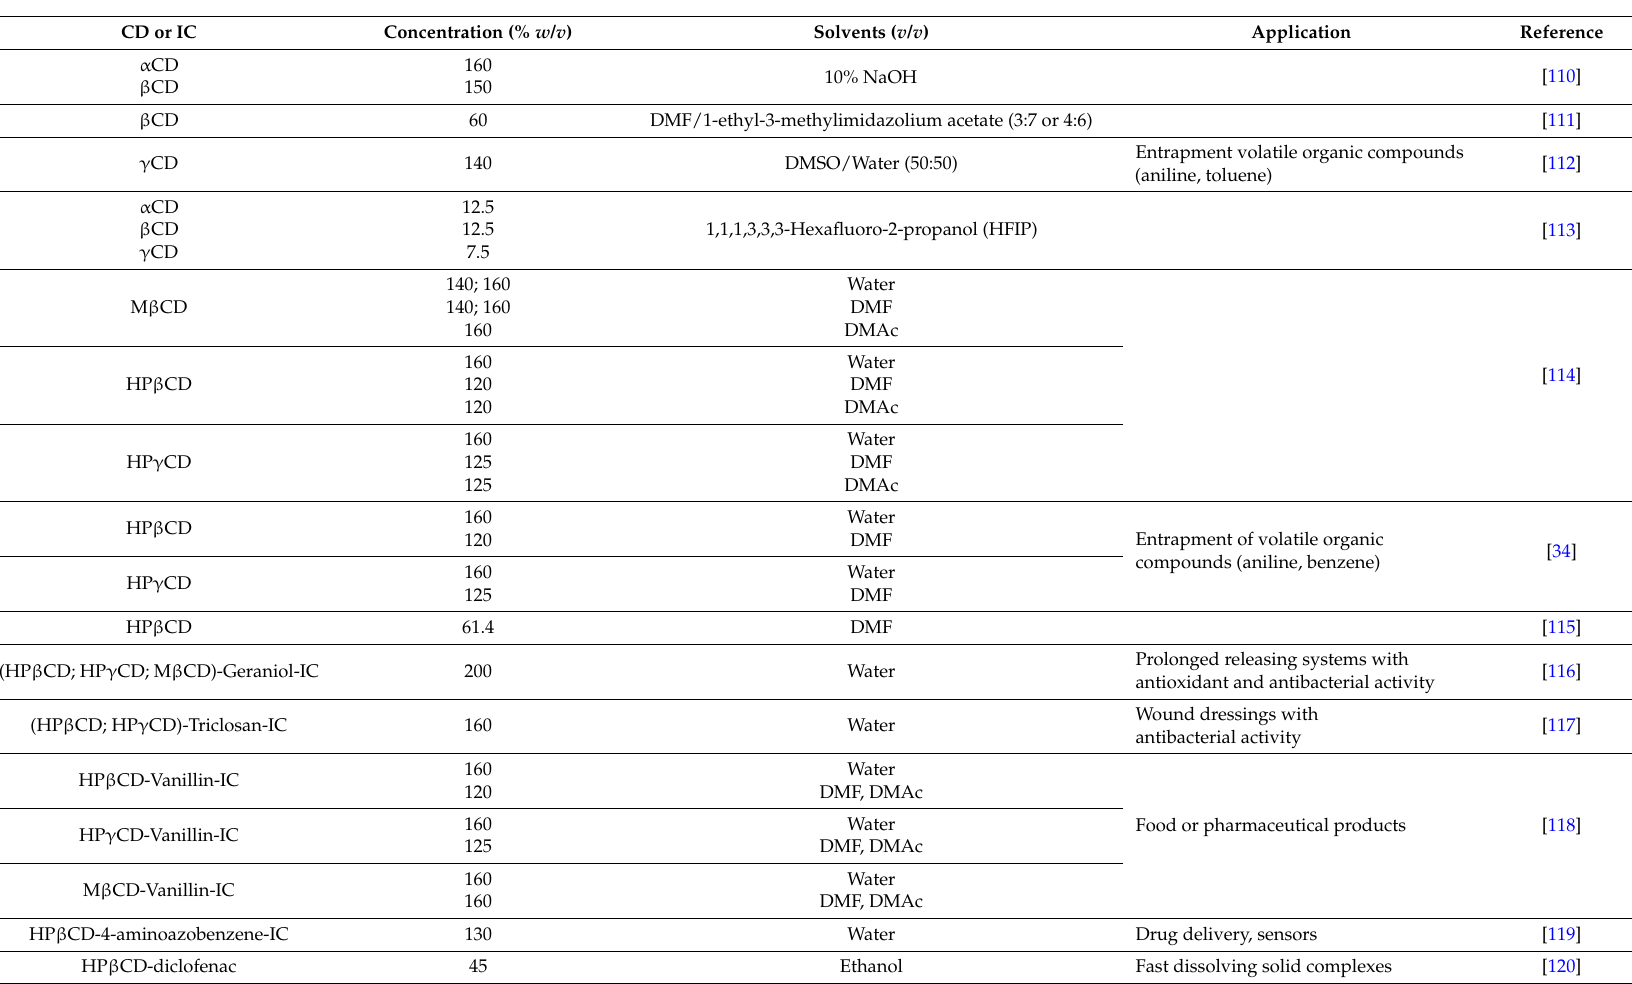
Table 1. Composition of bead-free electrospun mats obtained from CDs or CD-inclusion complexes (IC) and their